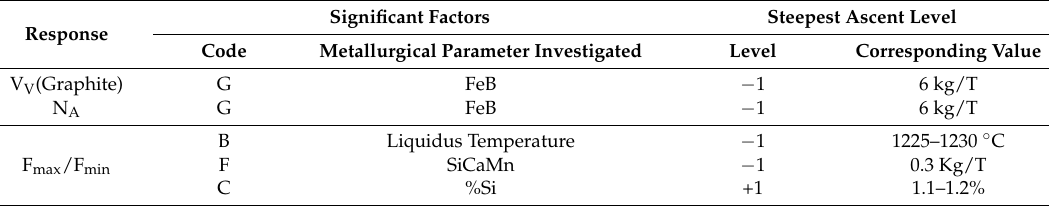
Table 10. Significant factors and levels providing an increase in the selected layer average